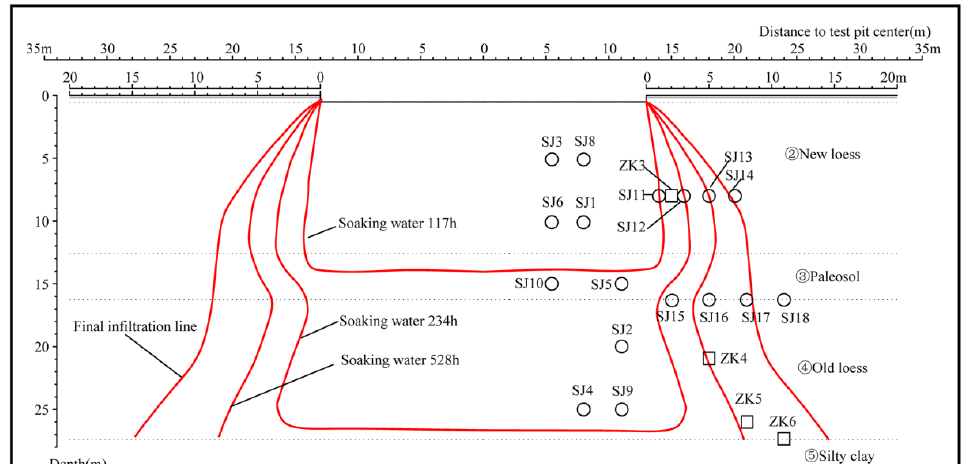
Figure 13. Comparison of water content before and after water immersion, ( a ) in the test pit, ( b ) 3 m from the edge of the pit, ( c ) 6 m from the edge of the pit, ( d ) 9 m from the edge of the pit, and ( e ) 12 m from the edge of the pit.